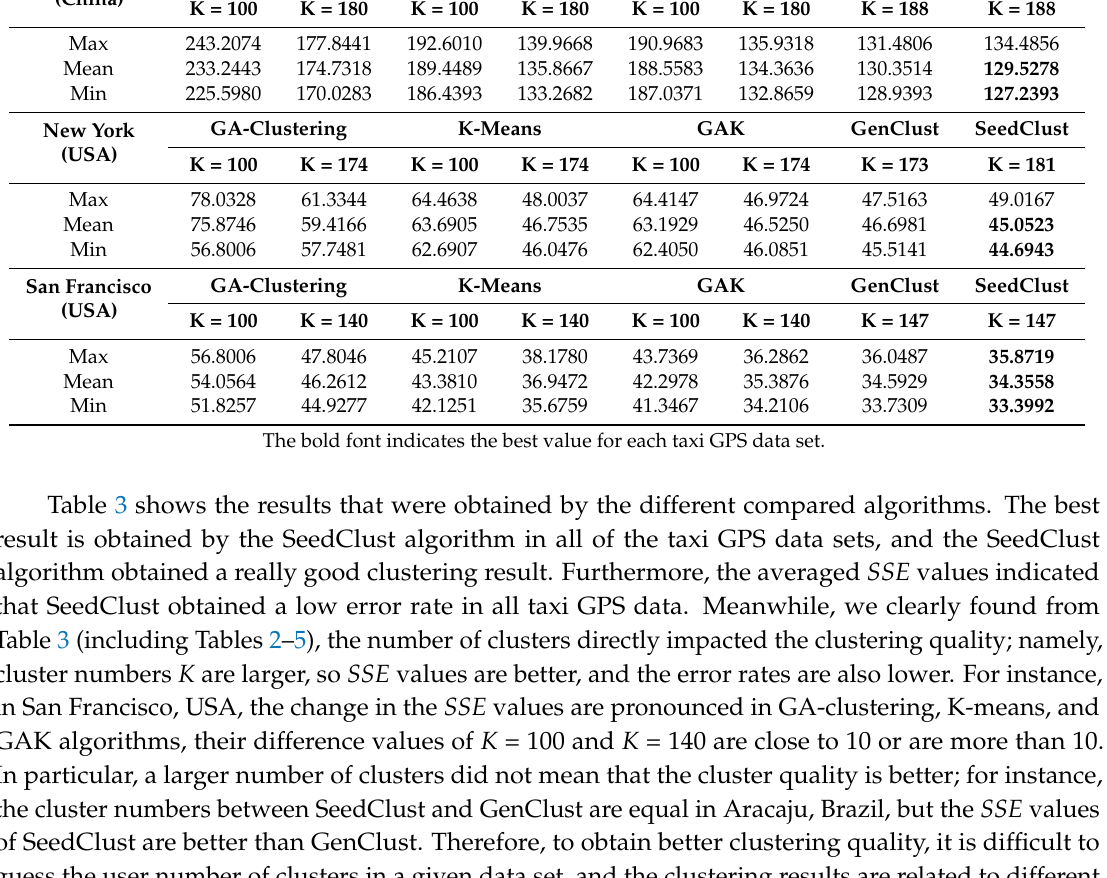
Table 3. The maximum, mean, and minimum values of SSE obtained by GA-clustering, GAK, K-means, and SeedClust algorithms for 20 different runs for four real-world taxi GPS data sets.